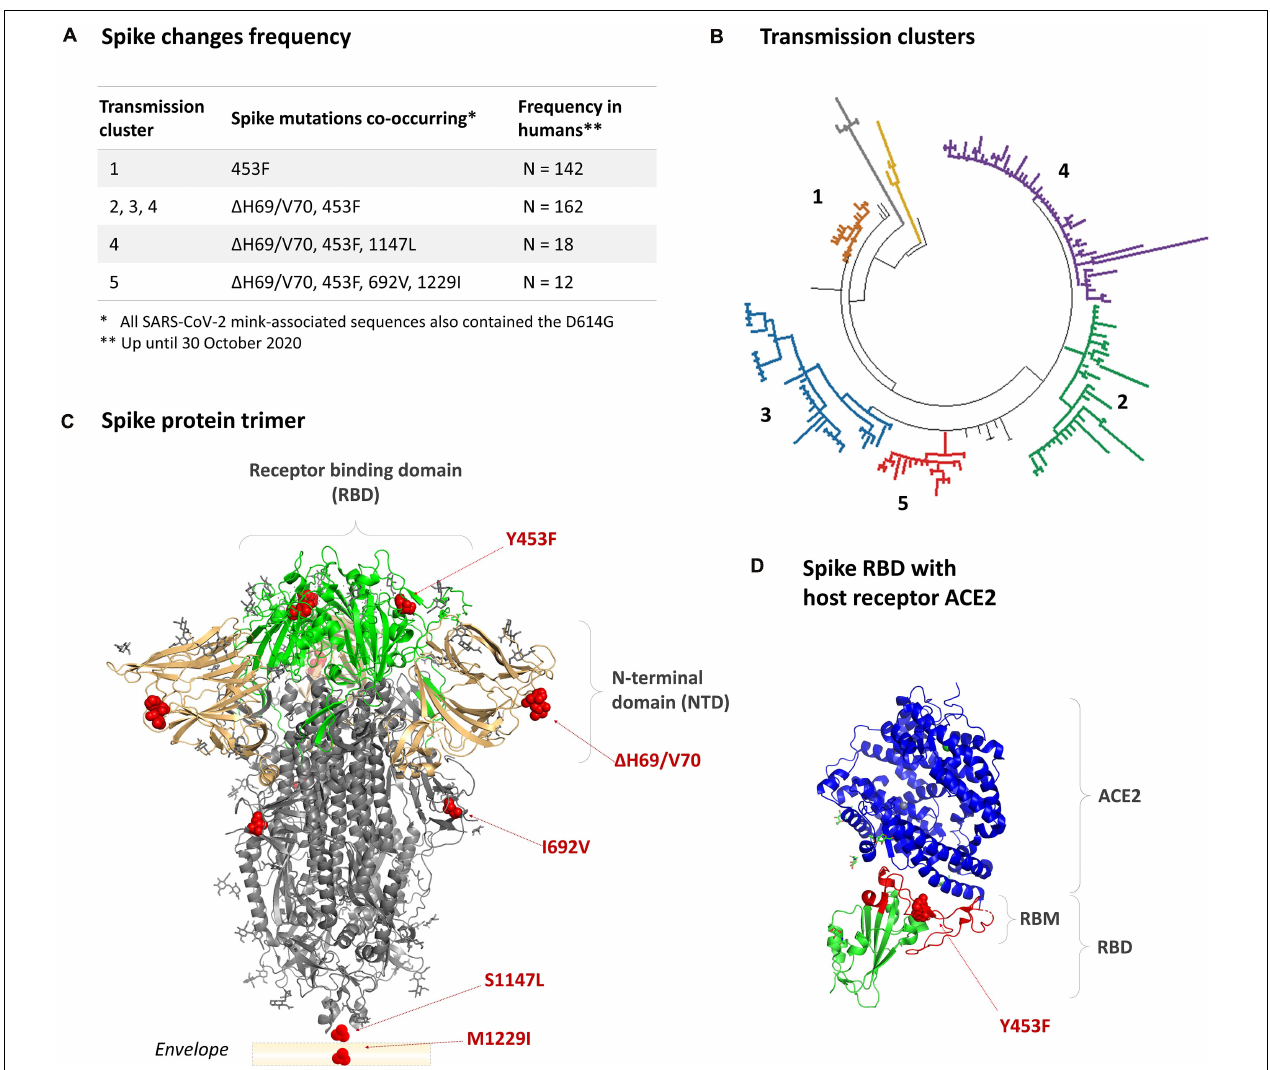
FIGURE 1 | The mink-associated mutations in the SARS-CoV-2 spike protein. (A) The combination and frequency of mink-associated spike changes detected in SARS-CoV-2 infected humans up until 30th October 2020. (B) Phylogenetic grouping of mink-associated variant transmission Clusters 1–5 (lineage B.1.1.298). (C) The crystal structure of a closed pre-fusion spike trimer [PDB: 6ZGE]. The positions of amino acid changes are indicated with red spheres. The receptor binding domain (RBD) is indicated in green, the N-terminal domain (NTD) in beige, and the S2 domain in gray. The regions encompassing the S1147L and M1229I substitutions are not within the crystal structure; however, their relative positions are indicated. (D) The location of the Y453F substitution in the receptor binding domain complexed with a host ACE2 receptor (blue) [PBD: